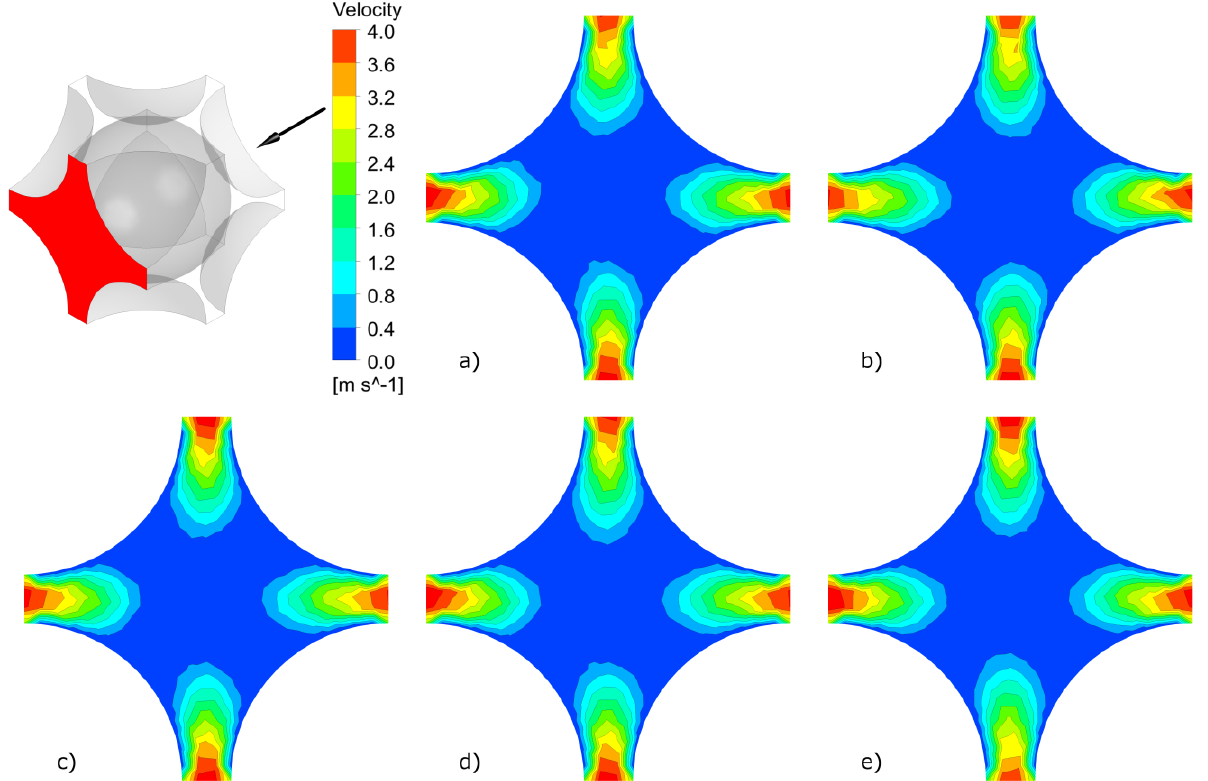
Fig. 9. Velocity magnitude on outlet surface obtained with the discretization method with additional cylindrical volumes R cyl% equal: a – 5.00%. b – 6.25%. c – 7.50%. d – 8.75%. e - 20.00%.